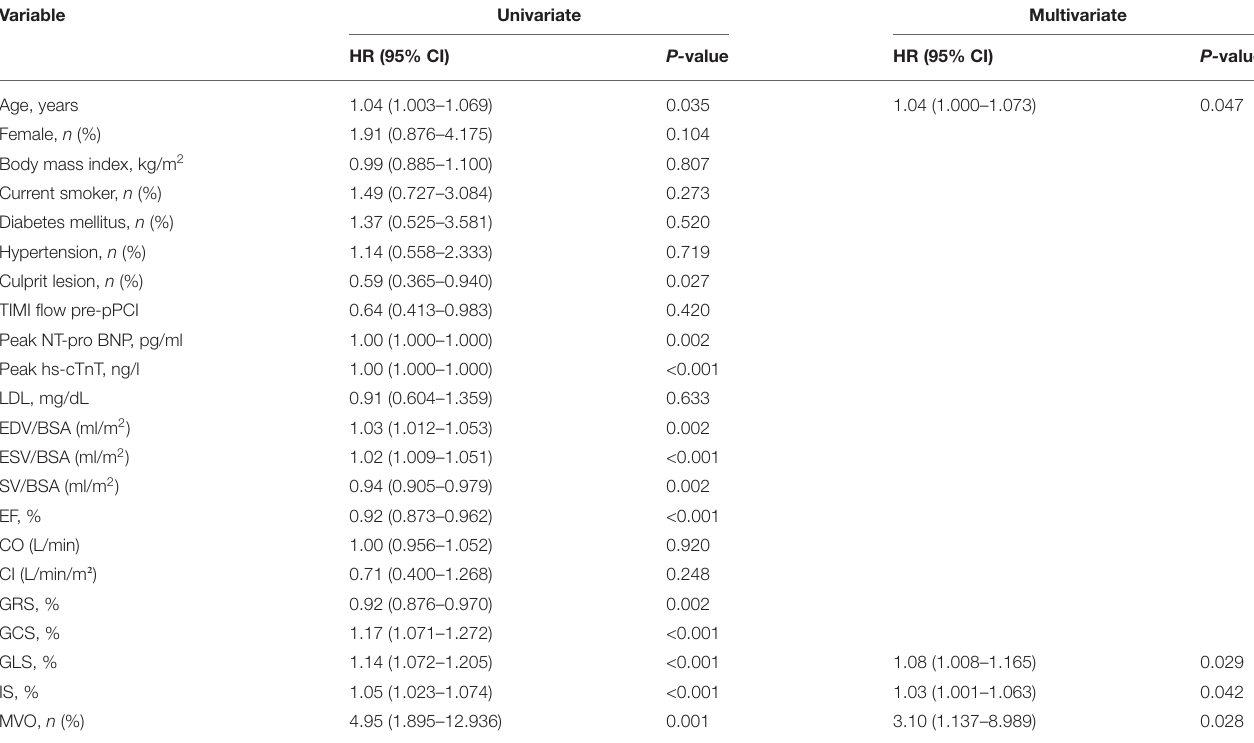
TABLE 3 | Predictors of MACE in univariable and multivariable Cox regression